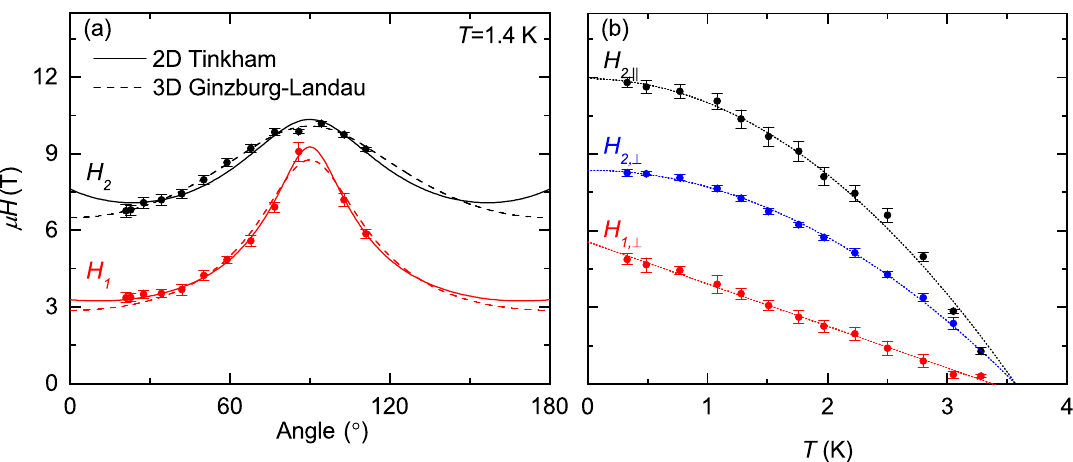
Figure 3. ( a ) Angle dependence of the characteristic fields, fitted with the two-dimensional Tinkham model (solid lines) and the three-dimensional Ginzburg–Landau model (dashed lines). ( b ) Temperature dependence of the characteristic fields for parallel and perpendicular fields. H 2 is fitted using a three-dimensional model and H 1 with the two-dimensional Ginzburg–Landau model. H 1 in parallel field cannot be unambiguously identified and is thus omitted from this